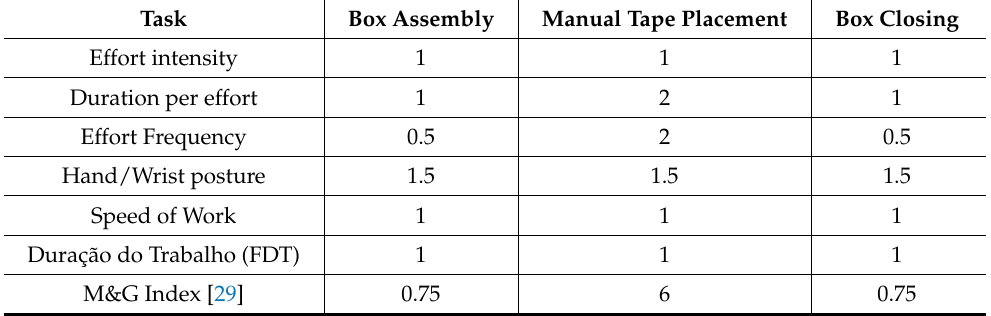
Table 5. Moore and Garg analysis before automation process.